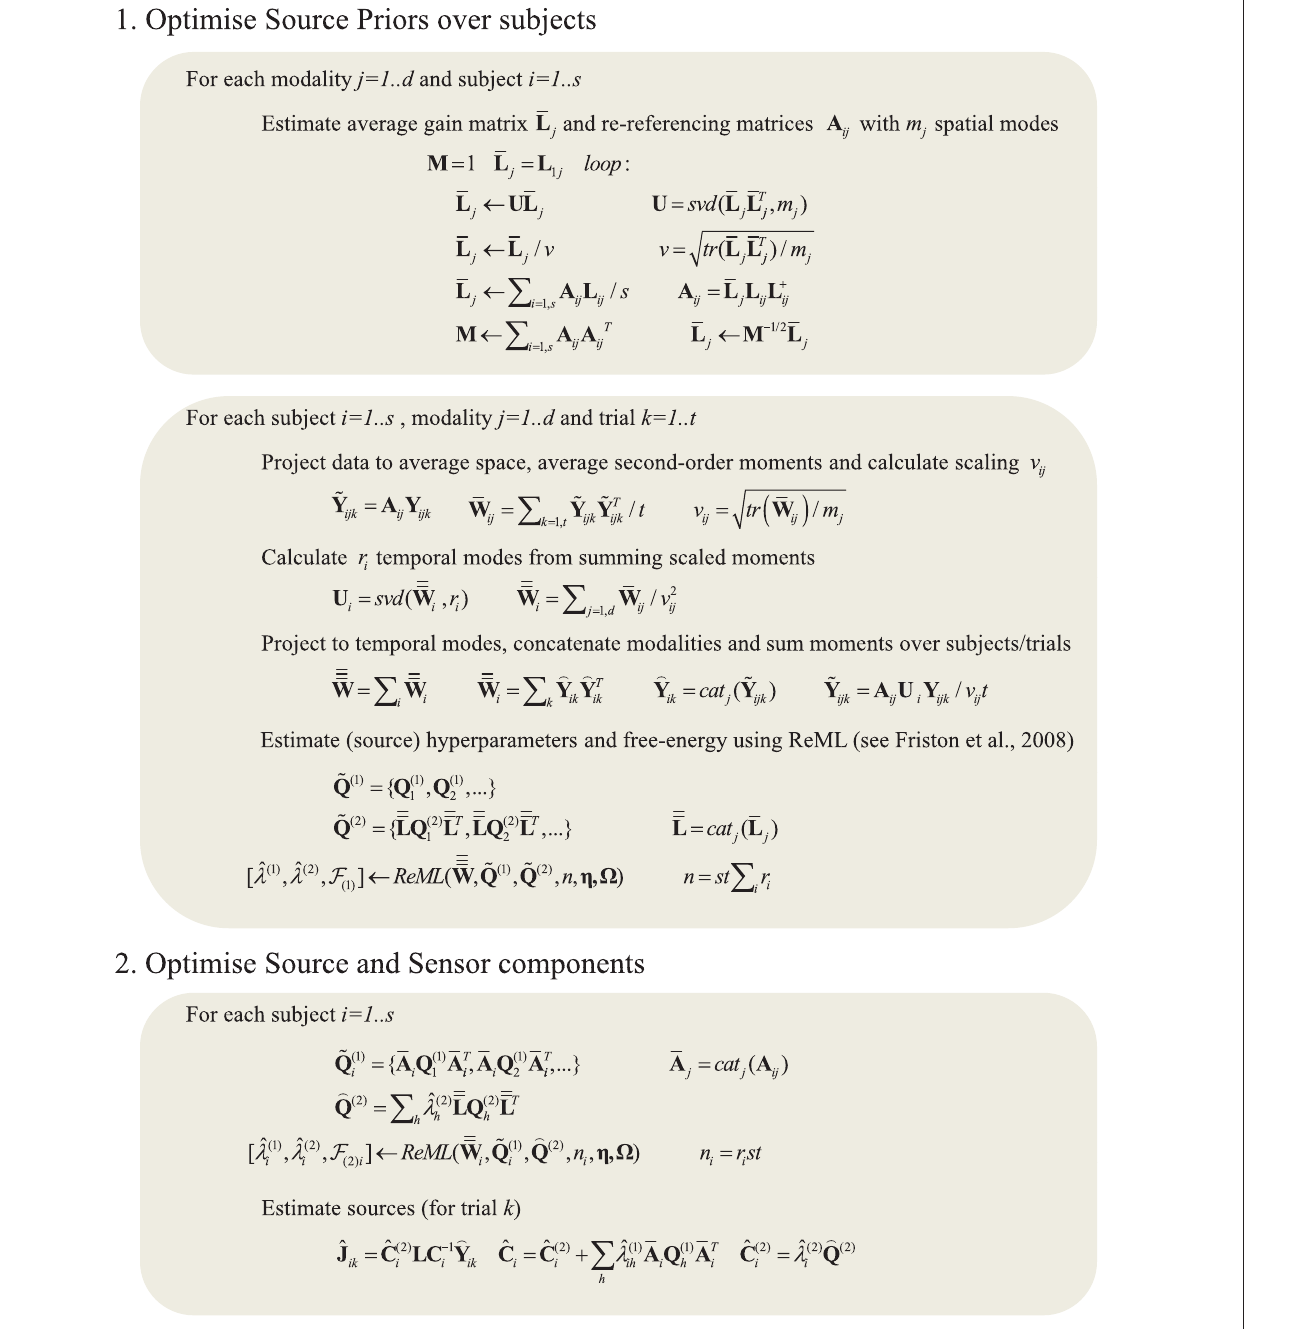
Figure 2 | Full pseudocode description for multi-subject, multi-modal MNM inversion based on spm_eeg_invert.m in SPM8. For details of the ReML algorithm and its precise updates using a Fisher-Scoring ascent on free-energy cost function, see Friston et al. (2008). (Note that an alternative “greedy search” algorithm is used for maximizing the free-energy in the case of MSP inversions.) The two main stages are: (1) optimizing the source component hyperparameters over subjects (by re-referencing each subject’s gain matrix and data to an “average” space), and (2) optimizing the sensor and source hyperparameters separately for each subject, using the single optimized source component from stage 1. For a single subject, the first stage has negligible effect. Note also that this example